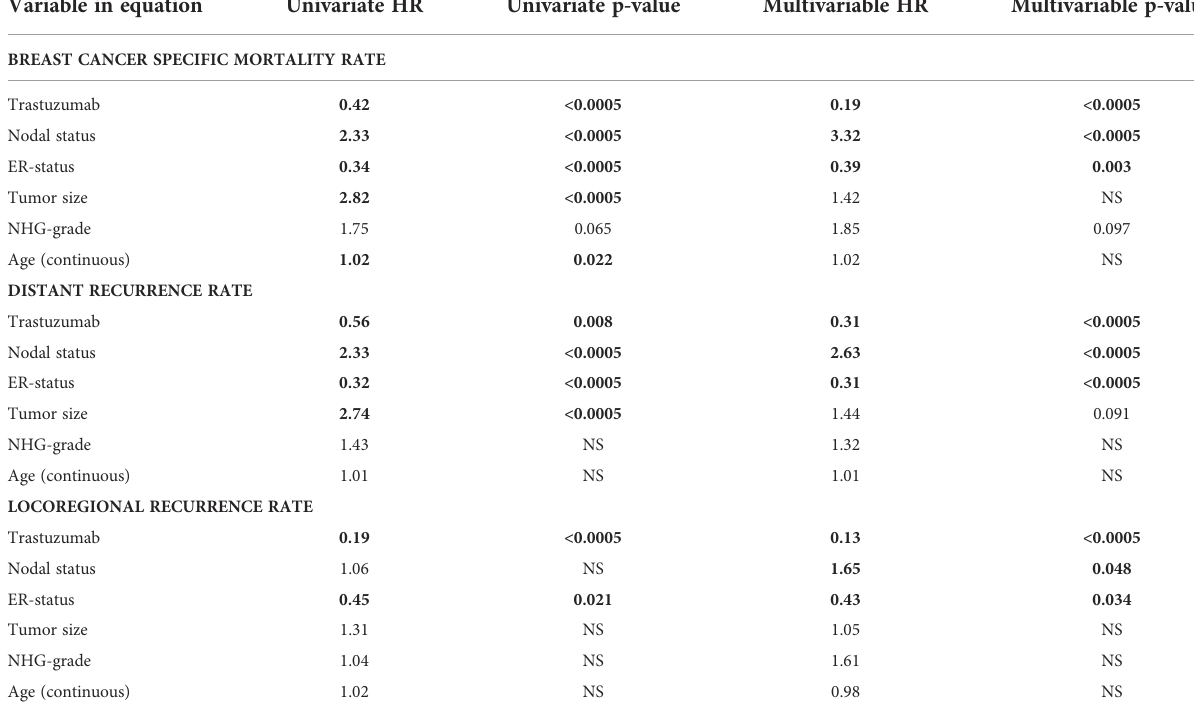
TABLE 3 Multivariable cox regression